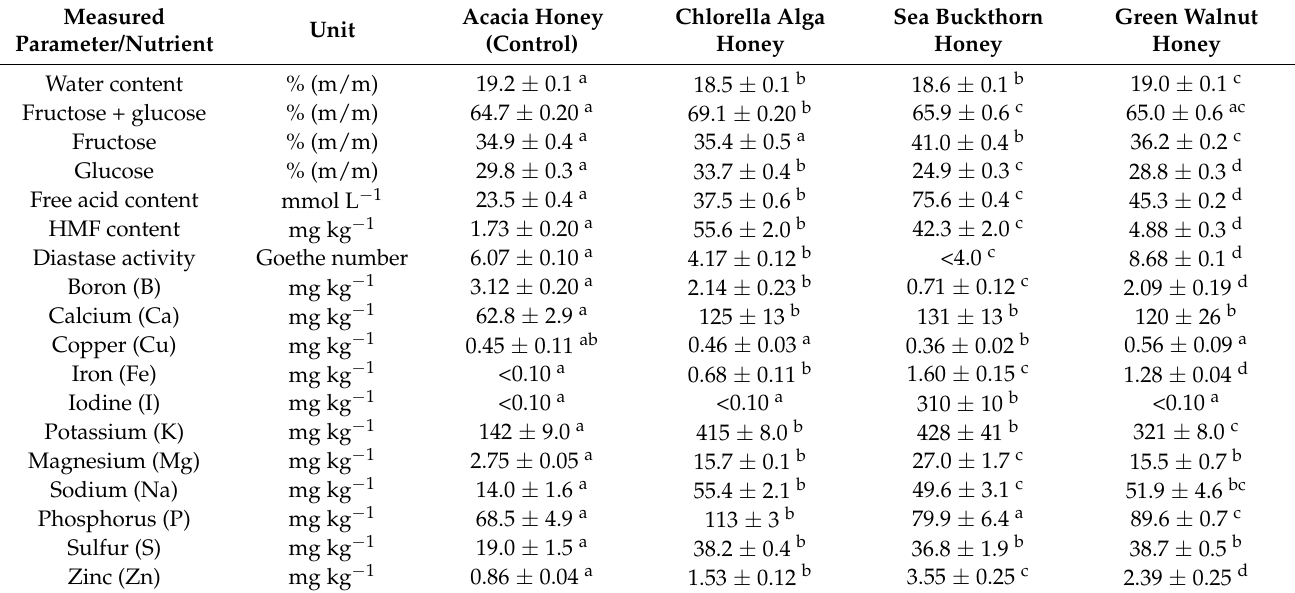
Table 1. Composition of the tested honey of selected plant extracts (i.e., chlorella alga honey, sea buckthorn honey, and green walnut honey) compared to the acacia honey used before treatments.